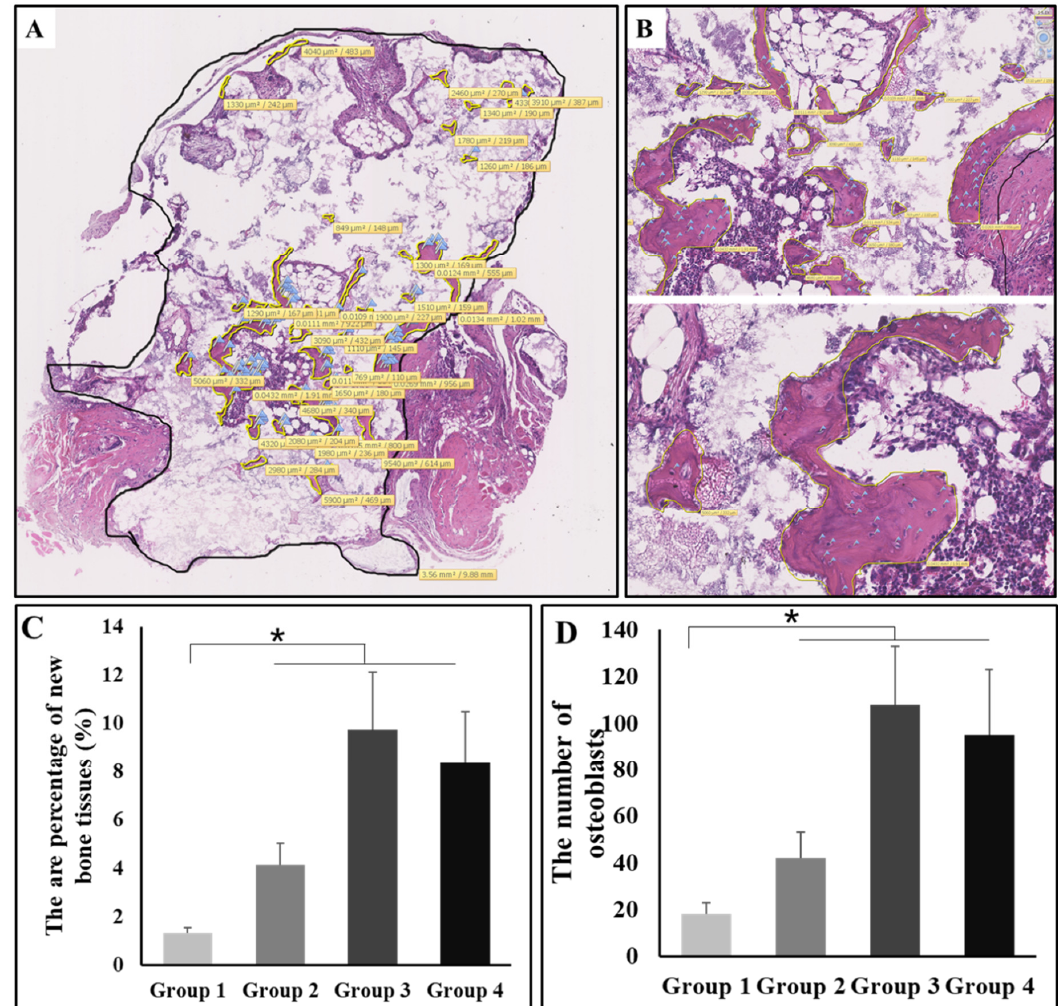
Figure 4. ( A ) The method about how the area percentage of new bone and the number of osteocytes were calculated. ( B ) The localized enlarged schematics of figure A. ( C ) The area percentage of new bone tissues in four groups ( n = 10) at week 8; comparison among group 1 and other three groups, * P < 0.05. ( D ) The number of osteocytes in four groups ( n = 10) at week 8; comparison among group 1 and other three groups, * P < 0.05. Group 1: negative control group; Group 2: running group; Group 3: weight-bearing group; Group 4: positive control group.